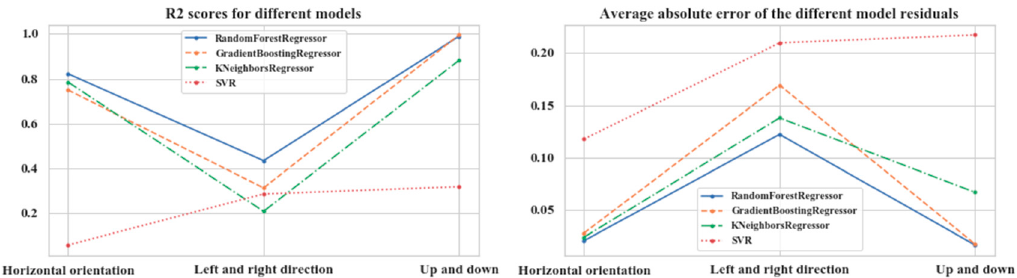
Figure 6. Comparison of regression model prediction results.